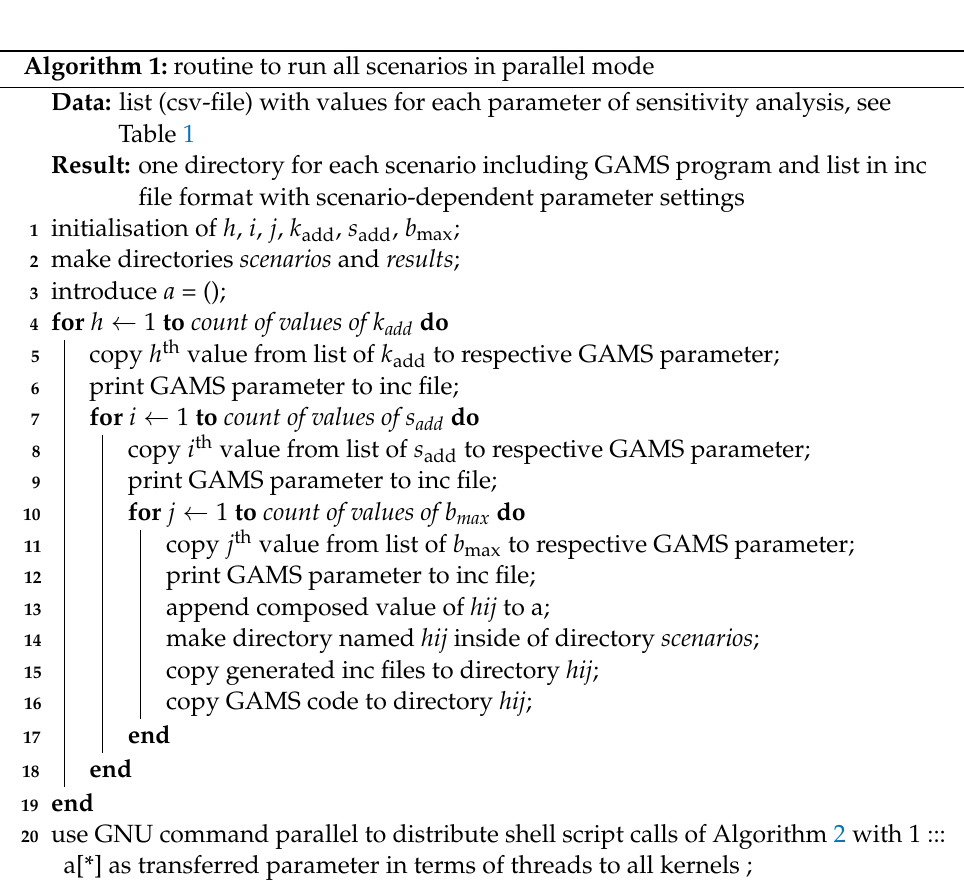
Algorithm 2: GAMS call for each scenario Data: Transferred parameter a from Algorithm